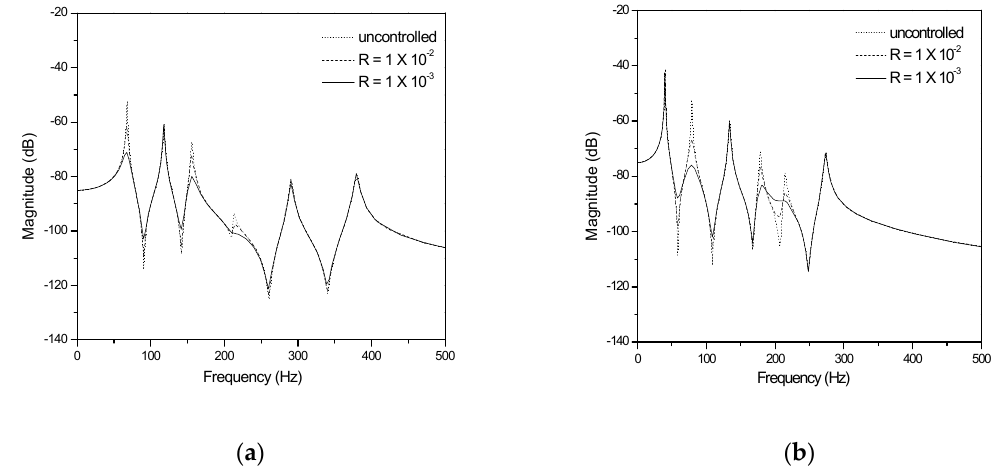
Figure 6. Magnitude ‐ frequency responses with two locations of stiffeners using linear quadratic Figure 6. Magnitude-frequency responses with two locations of sti ff eners using linear quadratic regulator (LQR) control: ( a ) Stiffener Case 1; ( b ) Stiffener Case 2. regulator (LQR) control: ( a ) Sti ff ener Case 1; ( b ) Sti ff ener Case